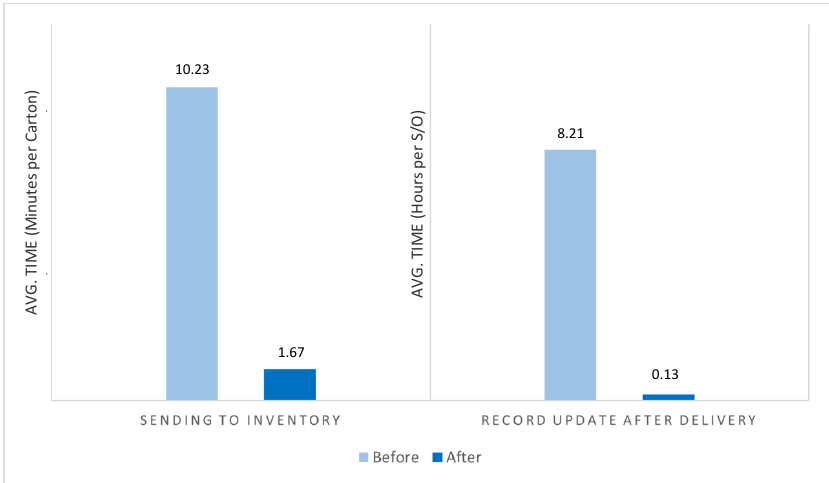
Figure 12. Comparison of the system efficiency before and after the implementation of the